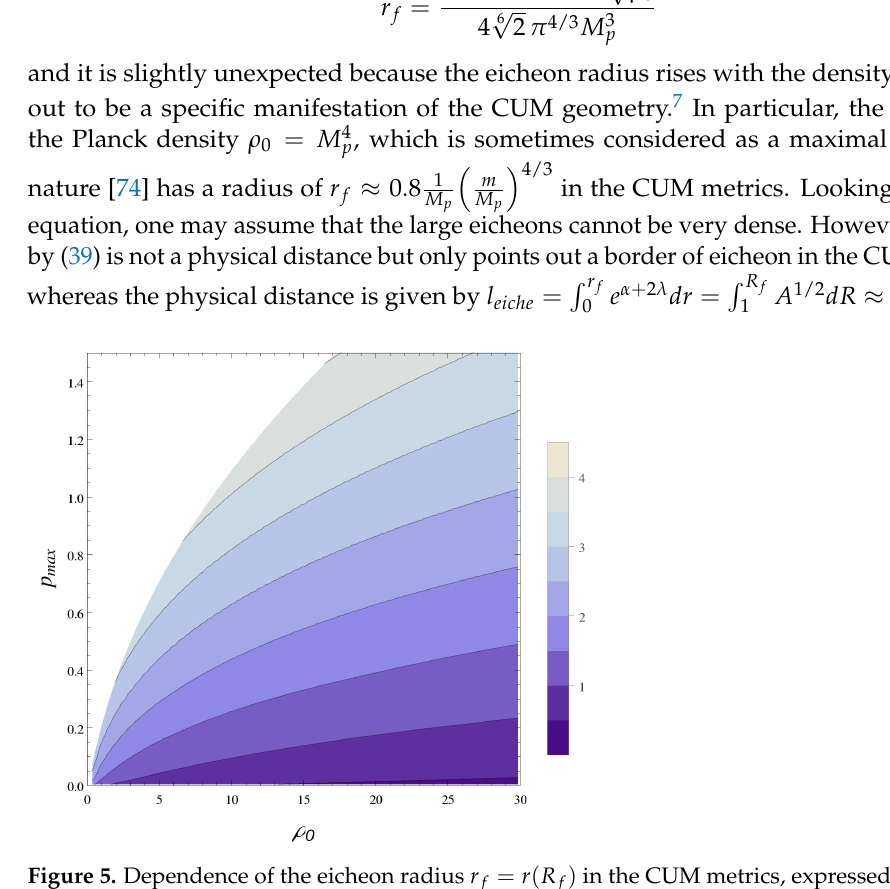
Figure 5. Dependence of the eicheon radius r f = r ( R f ) in the CUM metrics, expressed in the units of gravitational radius, on the density and maximal pressure (i.e., pressure in the eicheon center). Pressure and density are in the units of M 2 p r − 2 g